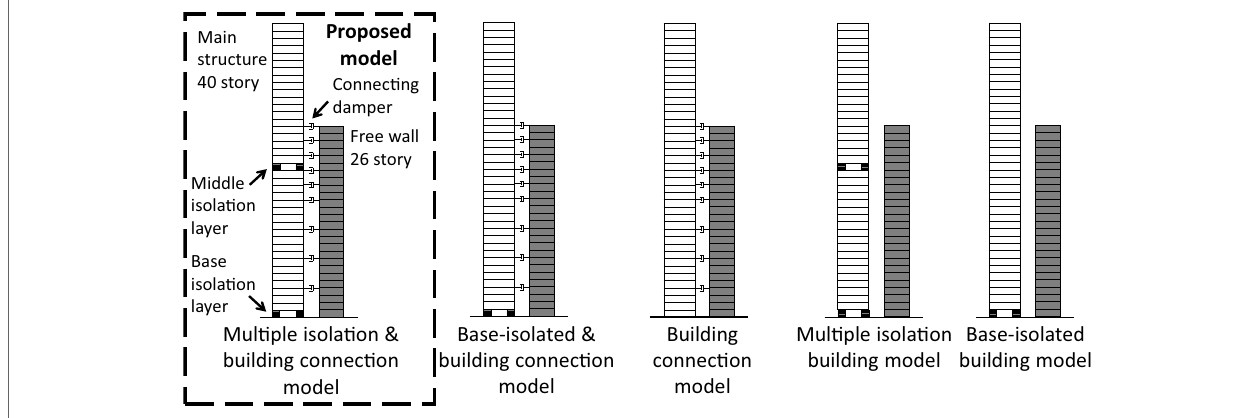
FIGURE 2 | Multiple isolation and building connection model (proposed model), base-isolated and building connection model, building connection model, multiple isolation building model, and base-isolated building model .